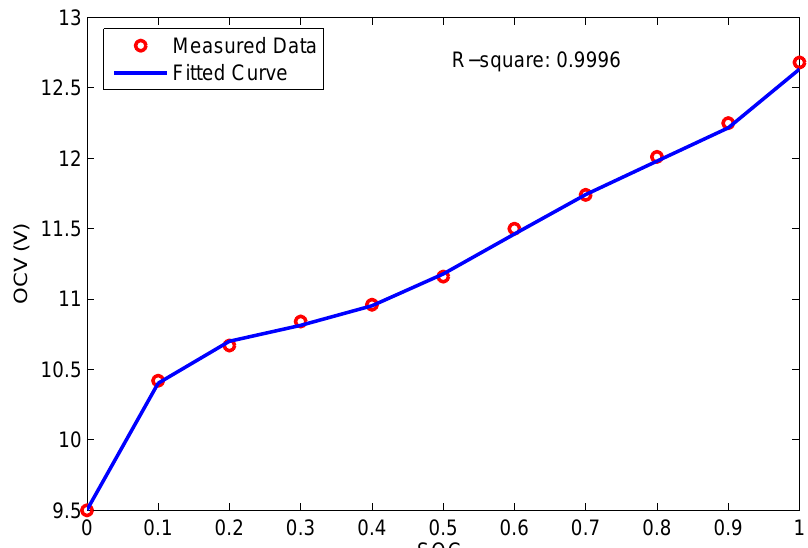
Figure 3. The relationship curve of open circuit voltage (OCV) versus state of charge (SOC).